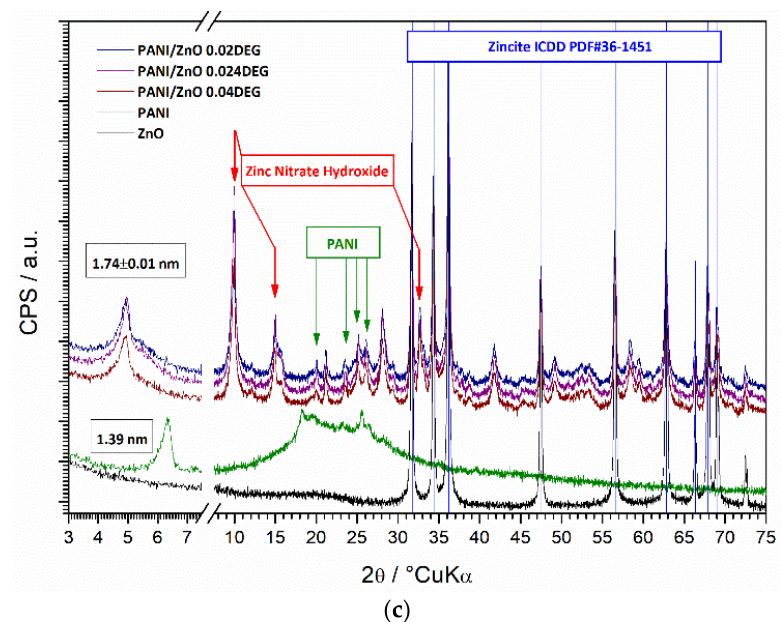
Figure 4. ( a ) Diffractograms of the PANI/ZnO composites, ( b ) qualitative analysis and observation of the mesostructural peak in PANI/ZnO composites, ( c ) structural parameters of the PANI/ZnO composites.